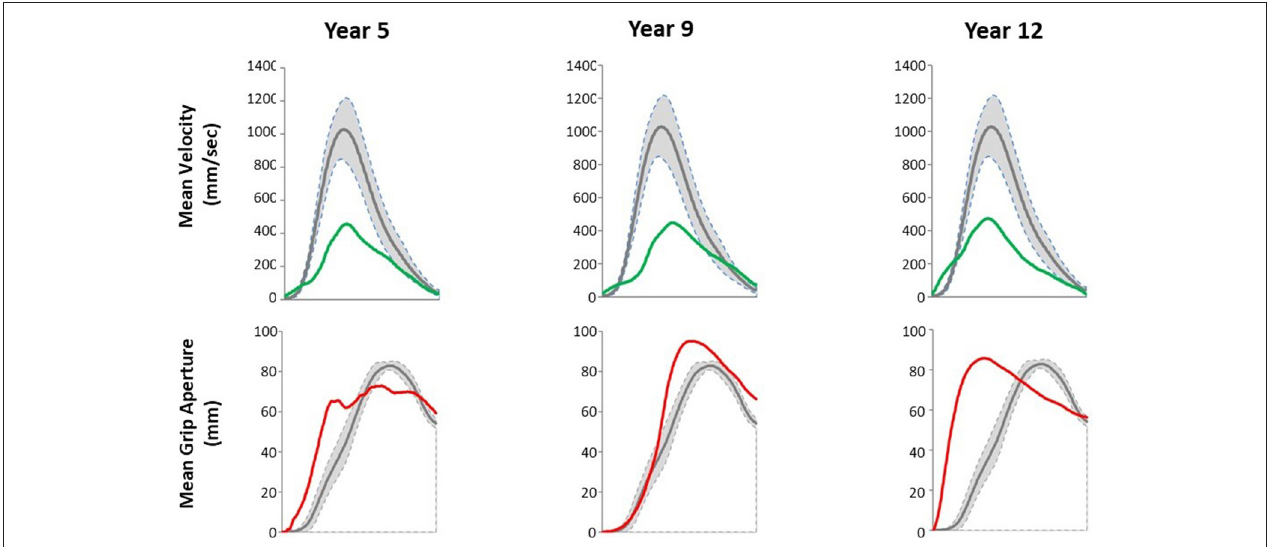
FIGURE 1 | Mean velocity and mean grip aperture profiles relative to a standardized prehensile movement time for a glass located on the right side for the patient (green and red) and in a group of six healthy controls (gray). In the control group mean ± SD is plotted.